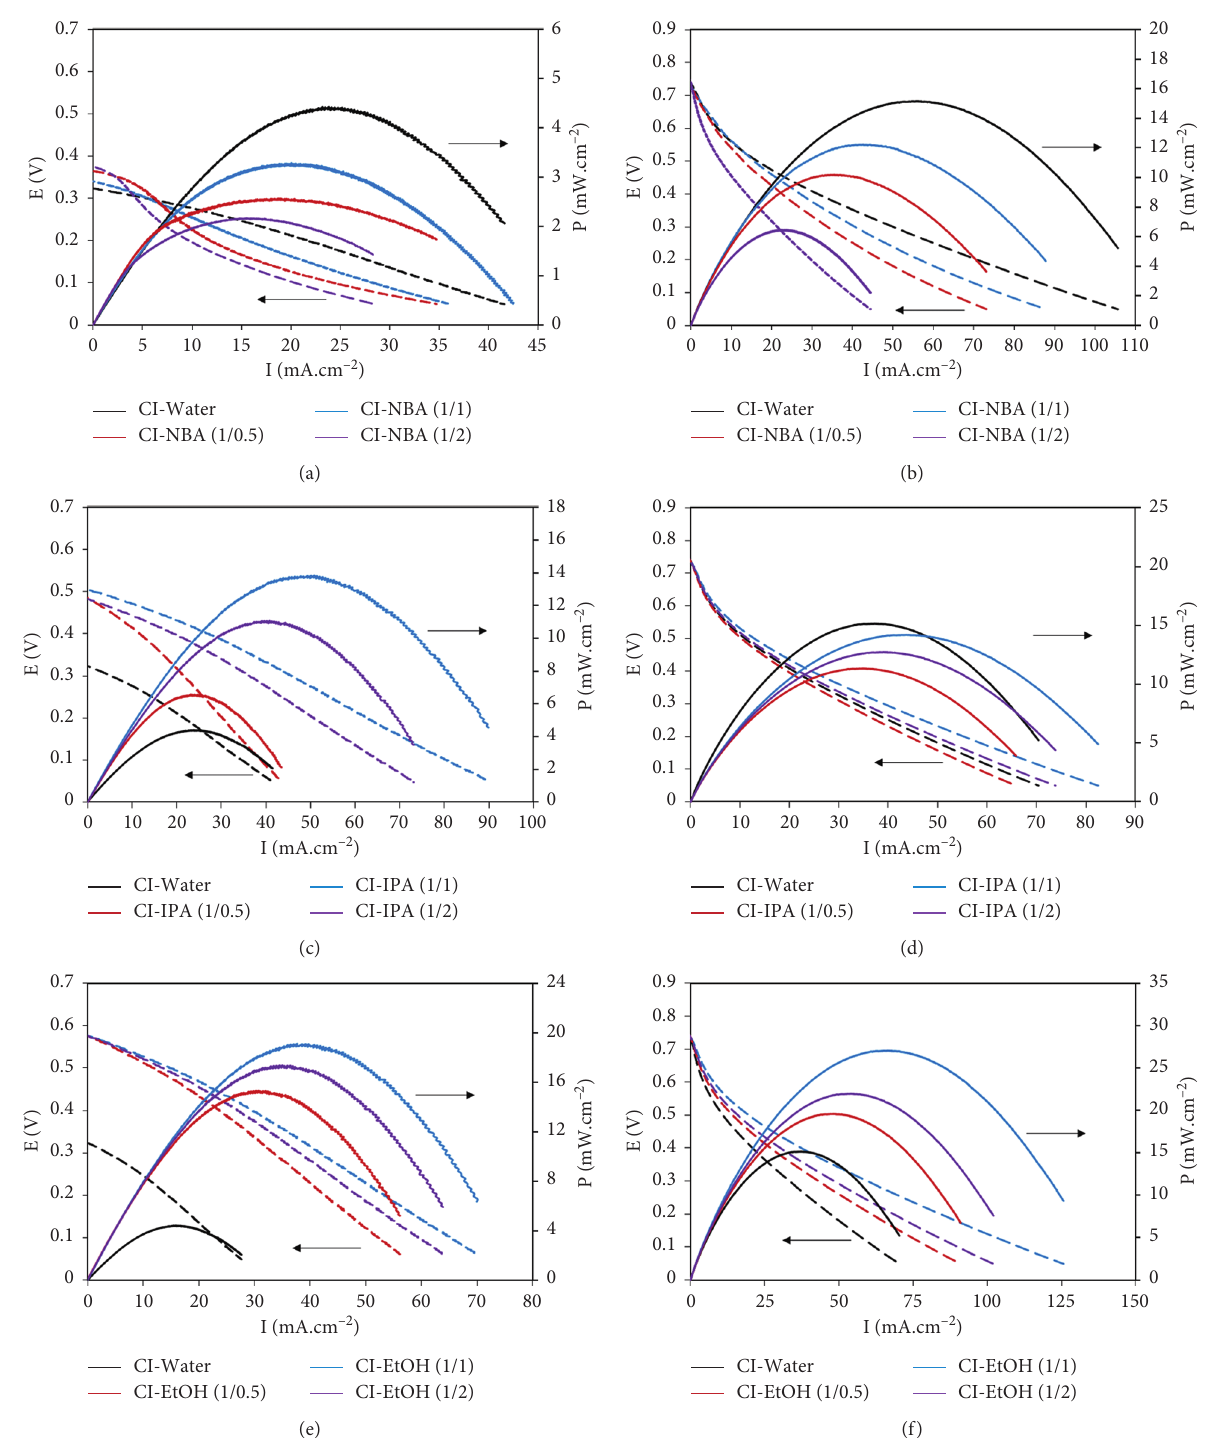
Figure 15: Polarization and power density curve of PEM-DEFCs (a), (c), (e) and AEM-DEFCs (b), (d), (f) using the anode-coated different catalyst inks. Cathode: O 2 flow with a pressure of 2atm. Anode: C 2 H 5 OH 2 M, 10mL min − 1 (with PEM-DEFCs). C 2 H 5 OH 2M+ NaOH 1M, 10mL min − 1 (with AEM-DEFCs). Temperature: 50 o